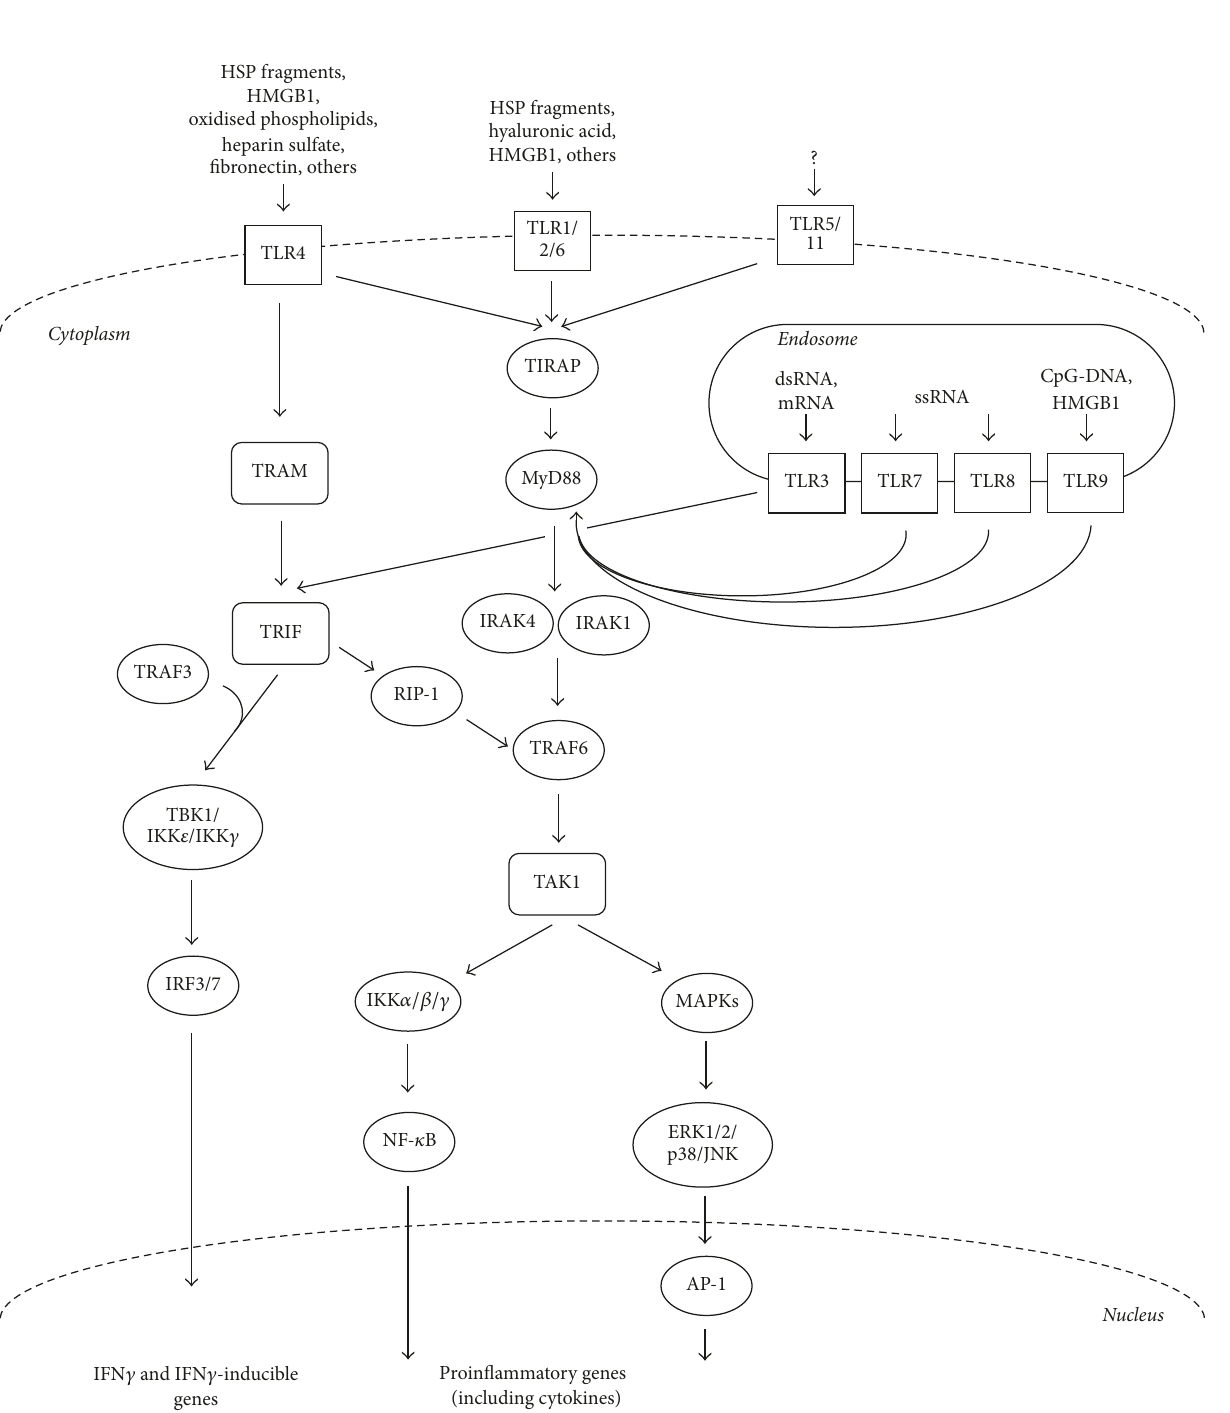
Figure 1: TLR signalling pathways. The two main pathways by which TLR signalling occurs upon stimulation by their ligands. These pathways are characterised depending on which of the adaptor molecules MyD88 or TRIF are involved. These signalling cascades result in the activation of NF-kB, IRFs, and MAP kinases, which promote the transcription of various immune response genes, including inflammatory cytokines and IFN 𝛾 -related genes. (AP-1, activator protein 1; ERK, extracellular signal-regulated kinase; IKK, inhibitor of kappa light polypeptide gene enhancer in B-cell kinase; IRAK, IL-1 receptor-associated kinase; JNK, c-Jun N-terminal kinase; MKK, MAPK kinase; RIP1, receptor interacting protein 1; TAK, transforming growth factor-activated kinase; TBK1, TANK-binding kinase 1; TRAF, tumour necrosis factor receptor-associated